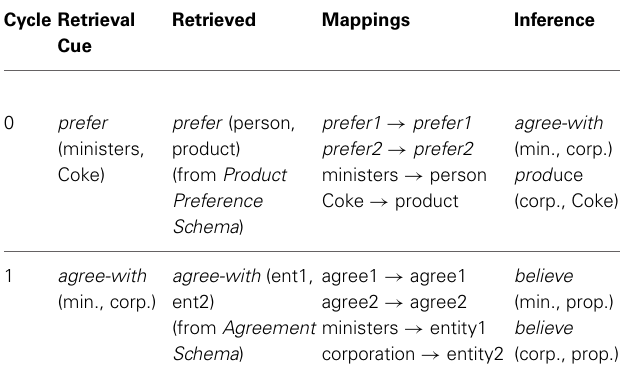
Table 1 | Illustration of the retrieve-map-infer cycle that governs explanation-generation in